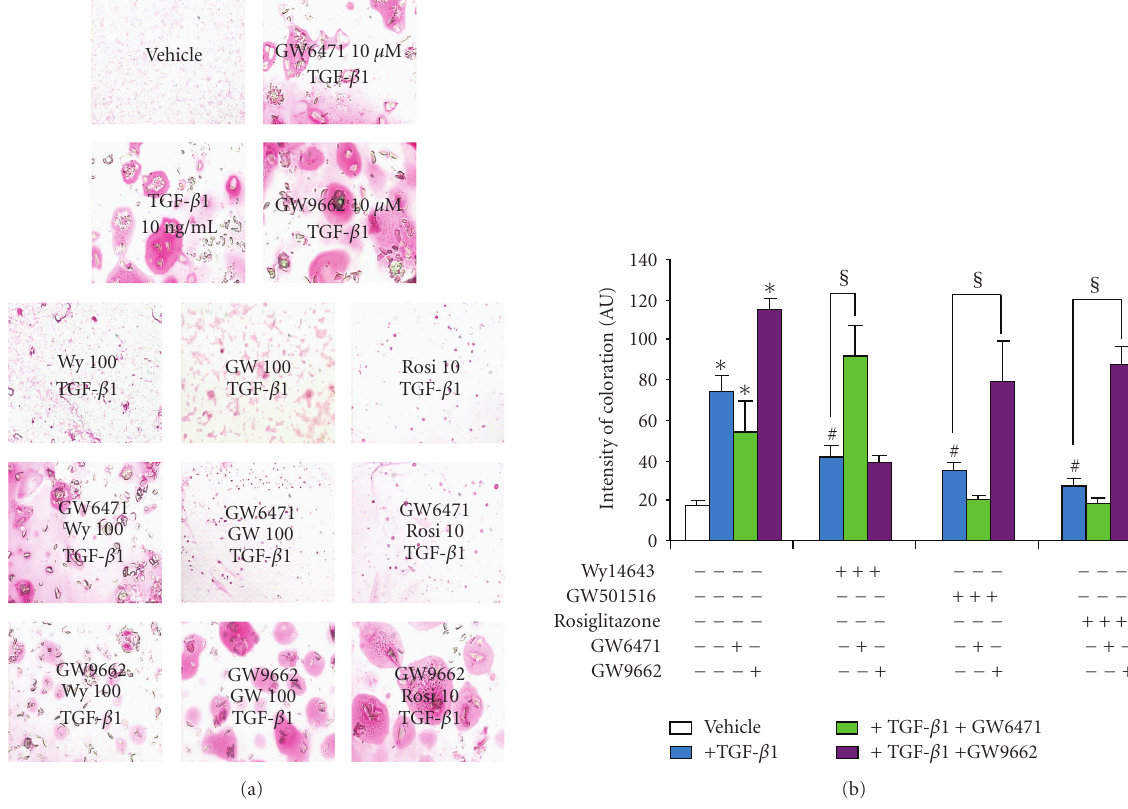
Figure 5: Selective reversion of anti-TGF- β 1 potency of PPAR agonists on collagens’ deposition in rat chondrocytes . Chondrocytes, embedded in alginate beads (5.10 4 cells per bead), were pretreated for 2 h with Wy14643 (100 μ M), GW501516 (100nM), or rosiglitazone (10 μ M), in the presence or absence of synthetic PPAR α (GW6471, 10 μ M) or synthetic PPAR γ (GW9662, 10 μ M) antagonists, before stimulation with 10 ng/mL TGF- β 1 for 72h. (a) Collagens’ deposition in the extracellular matrix (cell-associated matrix) after coloration of representative sections of beads ( n = 6, G: 400X) by Sirius red after 72h. (b) Measurement of Sirius red staining of the representative section of beads using NIH/Image software ( n = 4). Data were expressed as mean ± SEM and statistically significant di ff erences from the control were indicated as ∗ P < . 05; from TGF- β 1-treated cells as # P < . 05; from “TGF- β 1+agonists”-treated cells as § P < . 05.